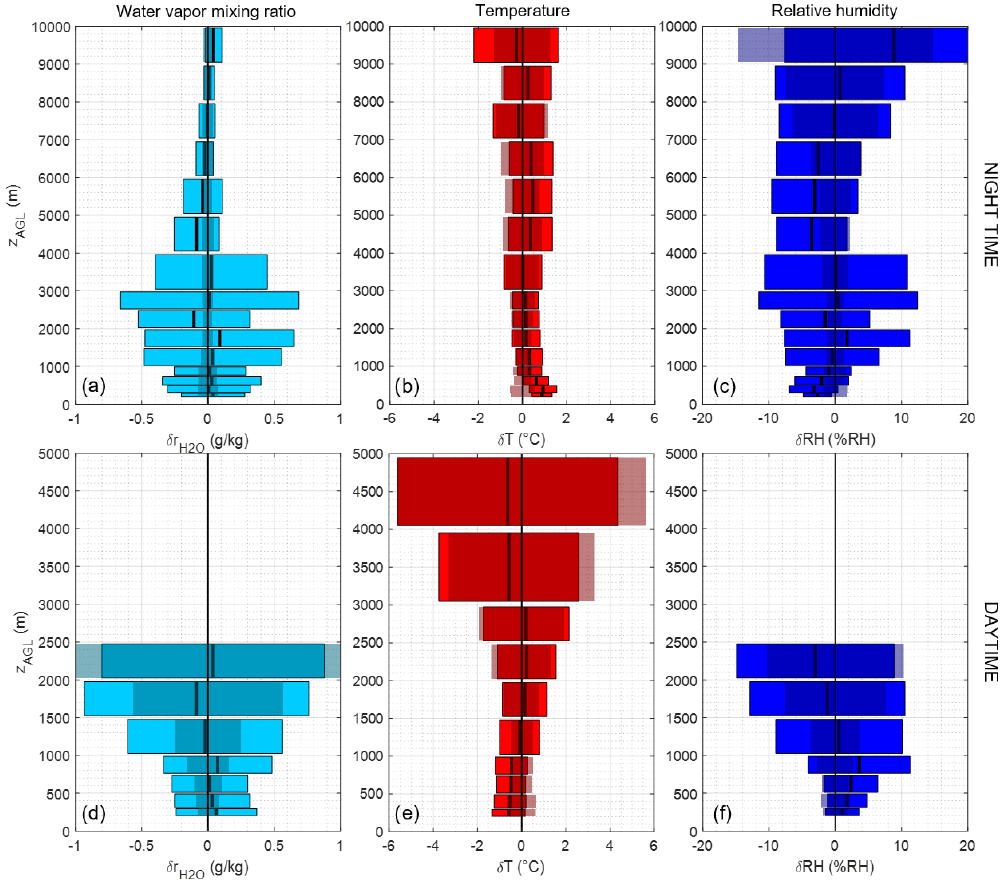
Figure 13. Residual deviations between lidar and Trappes radiosoundings in terms of WVMR, temperature, and relative humidity, for nighttime (a–c) and daytime (d–f) , with mean deviation (thick lines) and RMSE (colored rectangles). The error corresponding to noise levels on the lidar signal is shown as darker rectangles. Cloudy profiles have been discarded. Daytime measurements are limited to SNRs above 5 for R (WVMR) and 20 for Q (temperature).